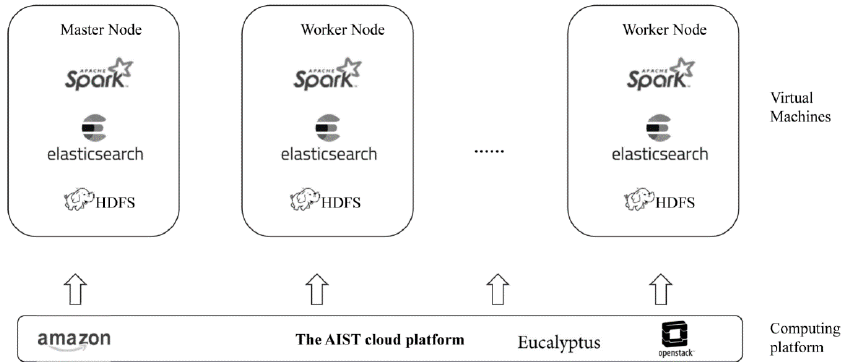
Figure 9. The testbeds for the proposed framework.